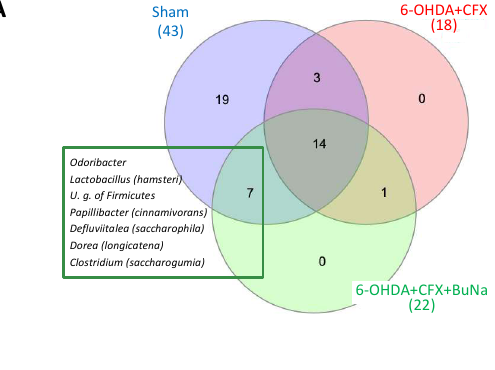
Figure 6. Co-occurrence network of species belonging to key genera discriminating Sham, 6-OHDA, CFX, and 6-OHDA+CFX mice. In the networks: the nodes represent the species, and the edges show nonparametric Spearman correlations with a correlation coefficient > 0.5 or ≤ 0.5 that is statistically significant ( p < 0.05 after Bonferroni correction), within green copresence interaction type, while in red mutual exclusion interaction type; node and label sizes are proportional to the relative abundance and its degree (the number of edges and nodes connected to each node), respectively. The colors of nodes represent their classification at the phylum level (green: Actinobacteria; blue: Bacteroidetes; pink: Firmicutes; yellow: Proteobacteria; grey: TM7).